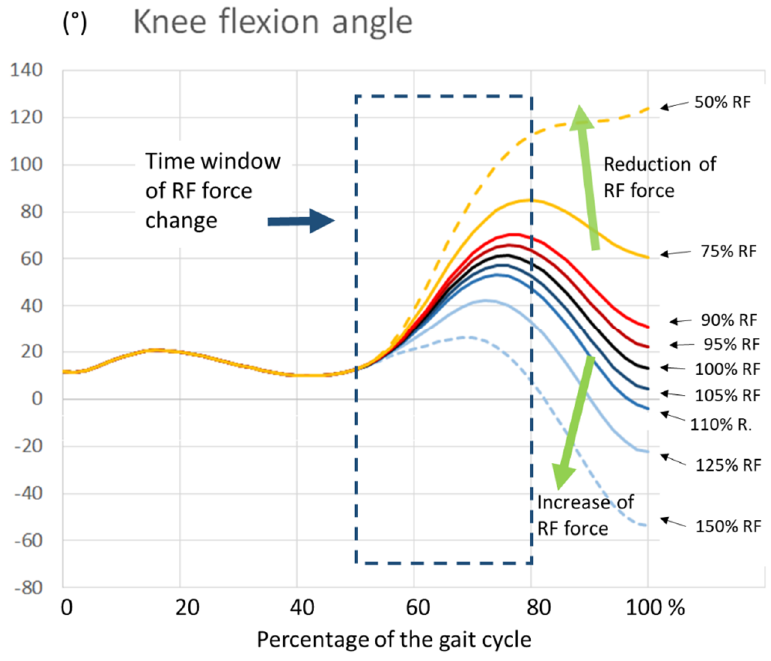
Figure 4. Changes of the knee joint angle with increasing and decreasing RF force. The hip joint was fully compensated (hip kinematics imposed).